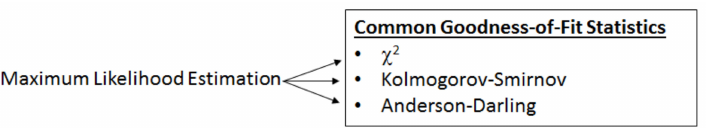
Figure 3. Maximum likelihood estimation is incorporated into common goodness-of-fit statistics, including χ 2 , Kolmogorov–Smirnov, and